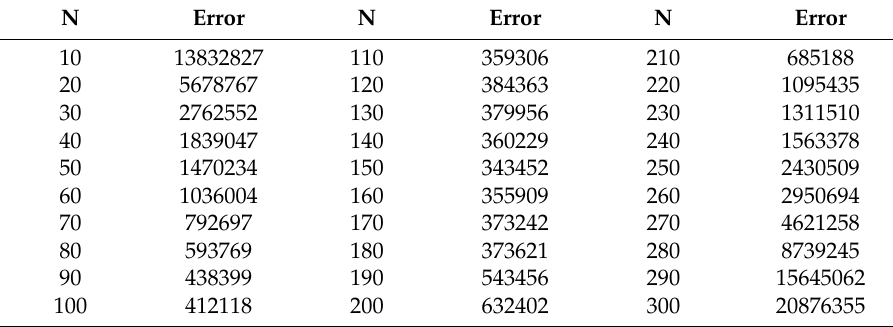
Figure 6. The MSE results with different number of hidden layer nodes. Table 3. The MSE results with different number of hidden layer